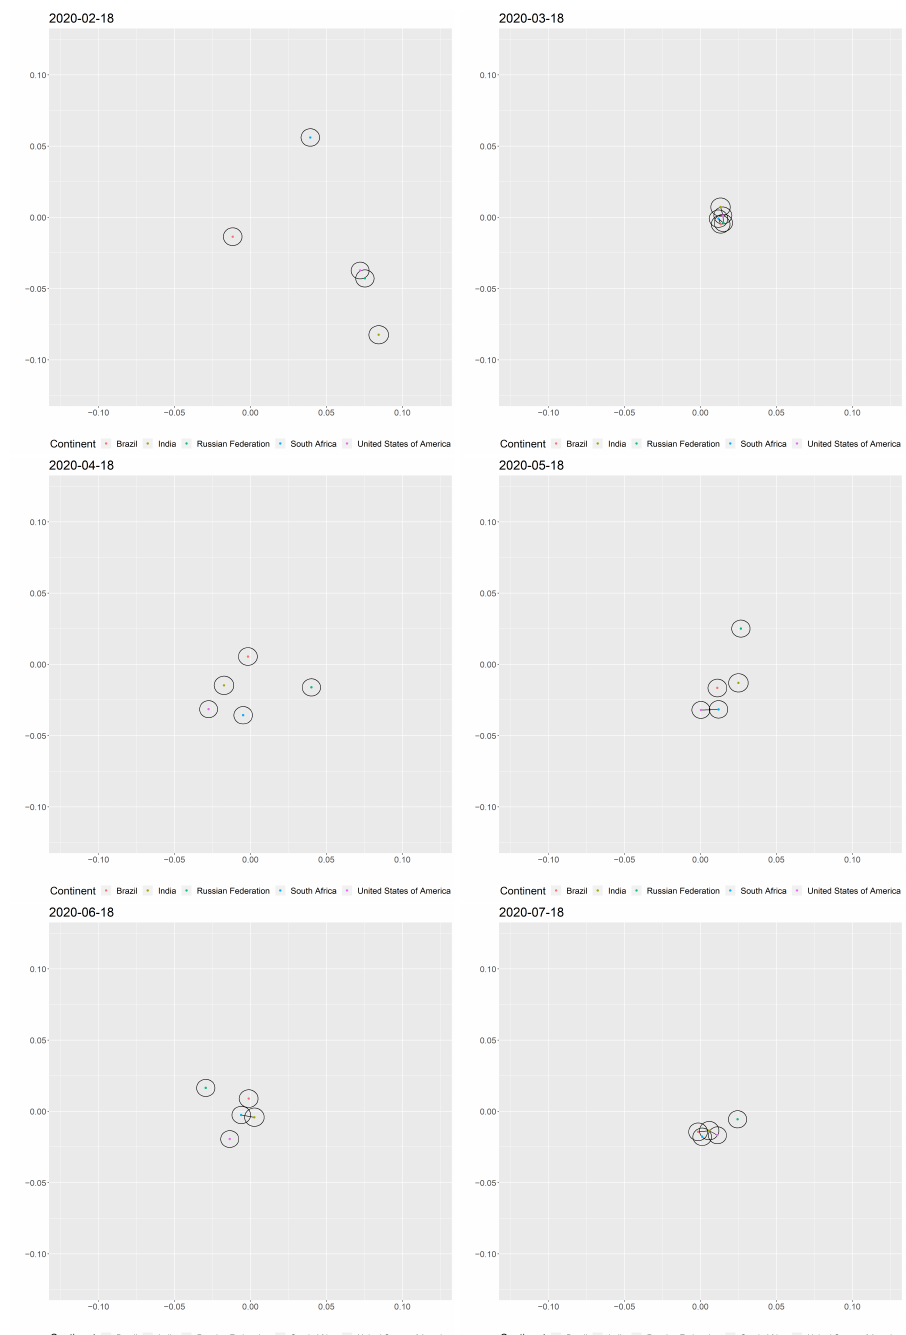
Figure 3. Snapshots of the latent positions of those countries that were in the top 5 list in terms of the cumulative number of confirmed COVID-19 cases on the eighteenth day of each month from February to July 2020. Inclusion of centers in two circles implies that the corresponding pair of countries had a similar level of prevalence, either because of possible transmission between the countries or because there was a common trend in the severity of community transmission. The line segment between two countries refers to a link between them on that day in the pandemic network. To view an animation of the changes in the latent positions in the pandemic space, please go to “Top 5 list” (https://drive.google.com/file/d/18ENvRXQlvaWJFSyBregzB_sLQ3Ewm7P7 /view?usp=sharing), or “All countries” (https://drive.google.com/file/d/1a0oWJJm47N9cQEsg02_